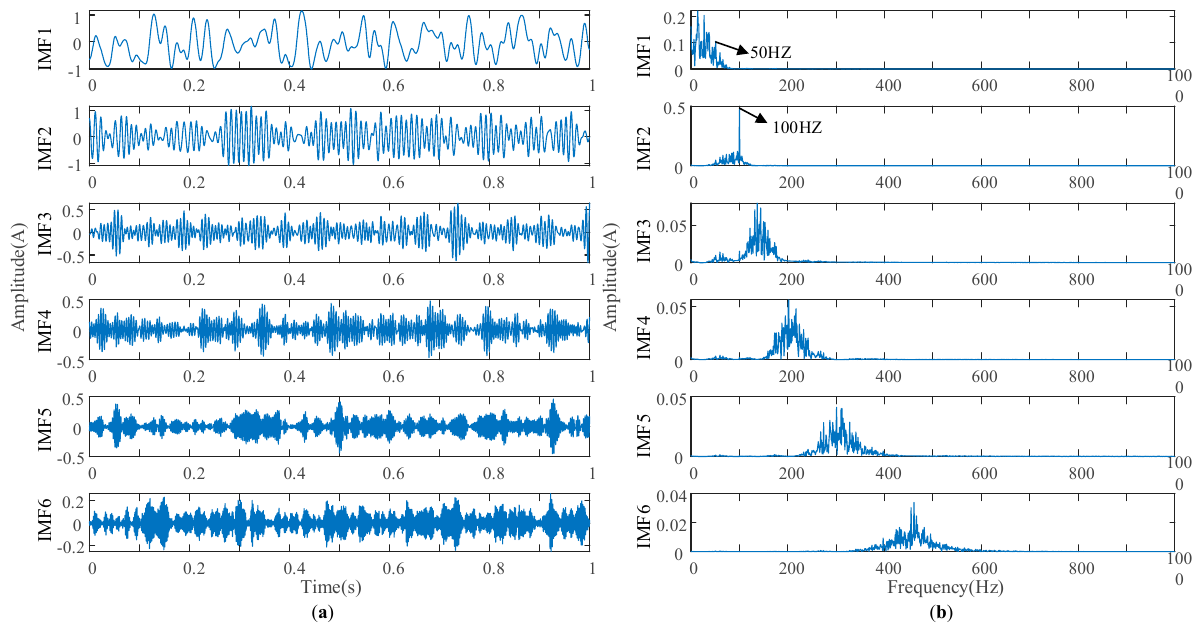
Figure 9. IMF components after VMD decomposition by first ACSRS: ( a ) Time − domain; ( b ) frequency domain.